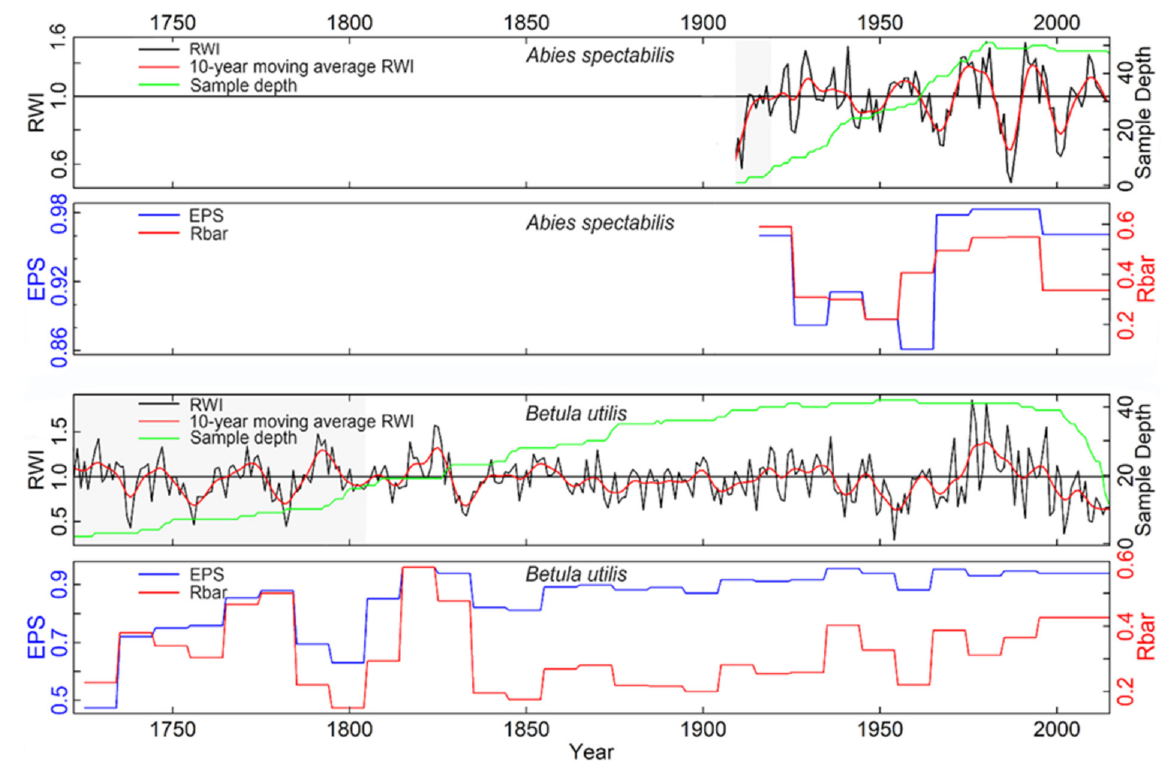
Figure 4. Tree-ring width standard chronology (black line), 10 year moving average of the ring width indices (red line), and sample depth (green line) for Betula utilis and Abies spectabilis . The light gray shade on the left of the chronology shows EPS less than 0.85. Blue and red lines below the respective chronologies are corresponding running EPS and Rbar (between-tree correlation), respectively, in 20-year window with overlap of 10